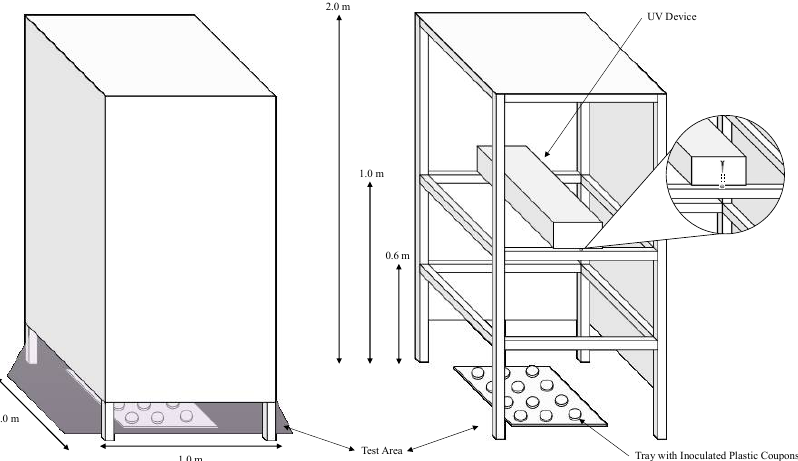
Figure 1. The enclosed UV tower constructed by the lab is intended to block the transmission of UV light outside of the testing area while a test device is in operation. This figure also depicts the completed construction and its intended operation ( left ), the testing area containing the tray with plastic coupons, and how to install the UV device therein ( right ).